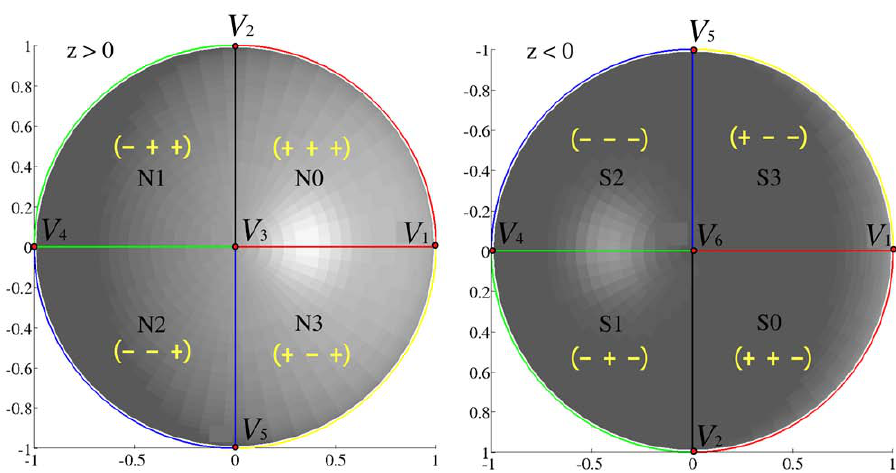
Figure 12. The sign patterns of the octahedron version of SACs.